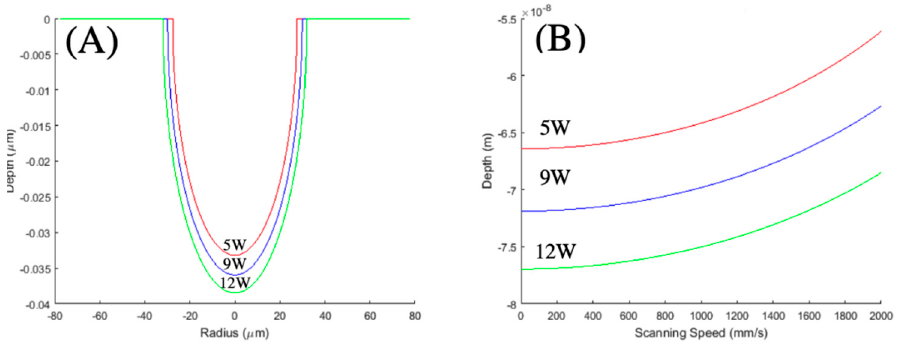
Figure 3. ( A ) Theoretical ablation depth profile as a function of radius and ( B ) theoretical ablation depth profile as a function of laser scanning speed for single pulsed laser with powers of 5, 9 and 12 W.